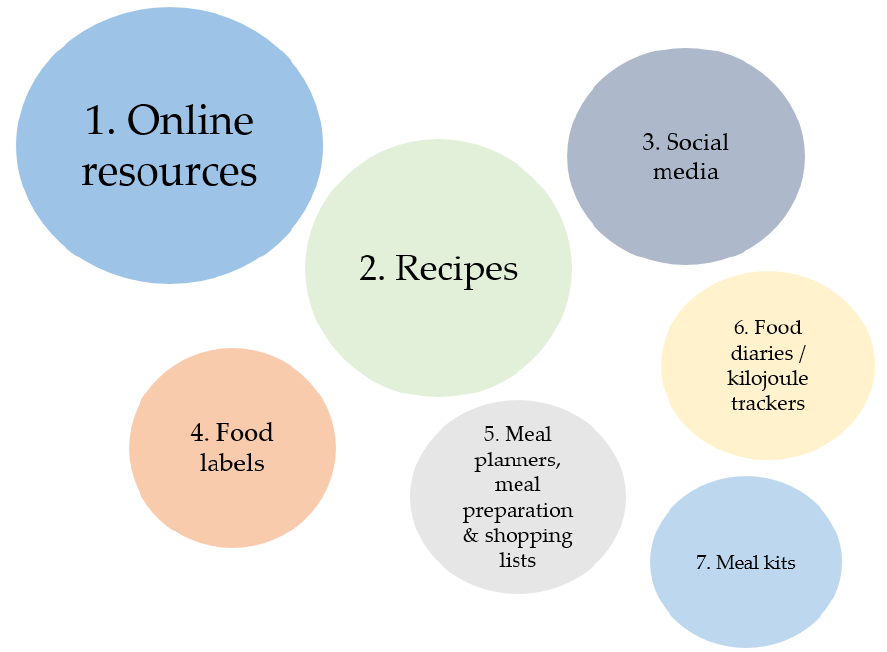
Figure 2. Summary of themes identified as resources or tools used to help in making healthier food choices among young adults who use the ‘No Money No Time’ website.